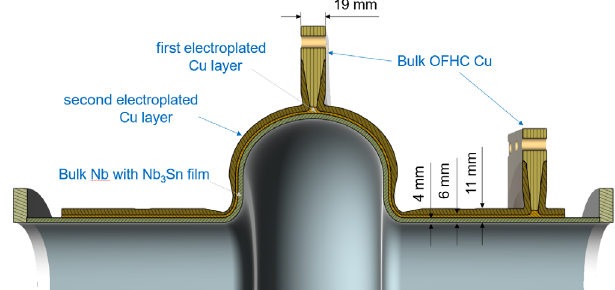
FIG. 7. Cross-section layout of the 952.6 MHz prototype cavity for